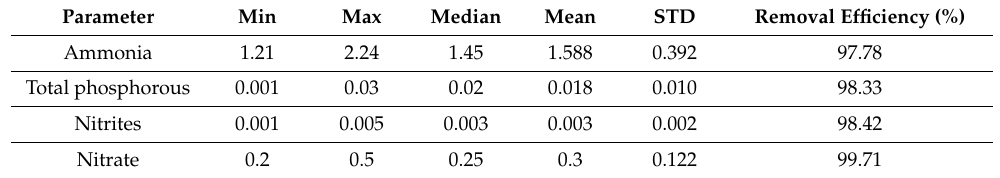
Table 4. Effluent quality characteristics and removal efficiency using the integrated treatment